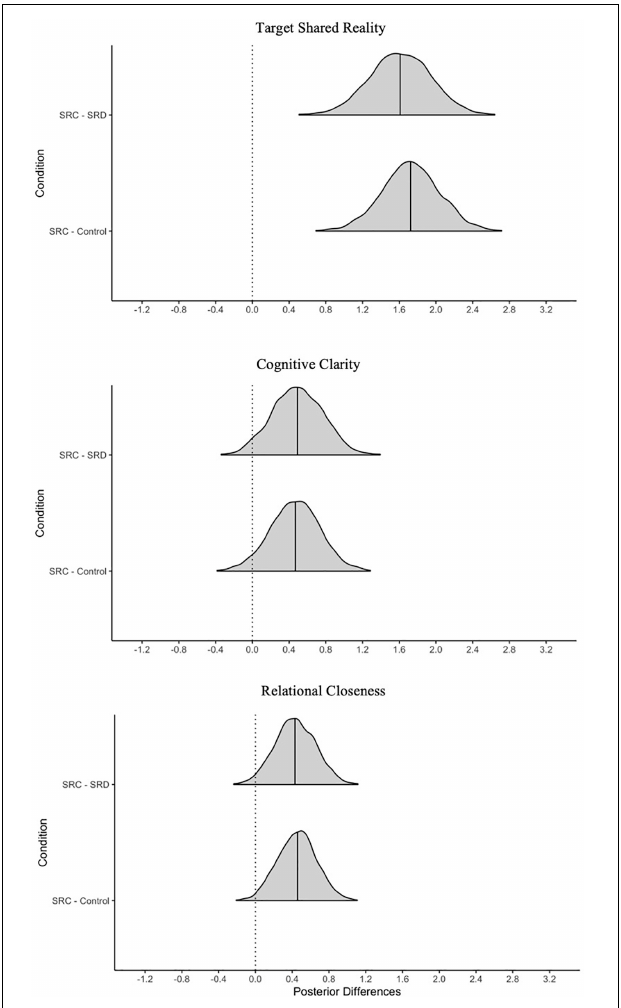
FIGURE 2 | Posterior differences in manipulation checks by condition. SRC, shared reality confirmed; SRD, shared reality disconfirmed; AMB, ambiguous. Solid line represents the 50th percentile and the dotted line on 0 = no